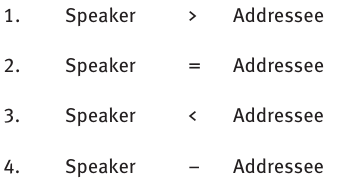
Figure 1: Possible distributions of access between speaker and